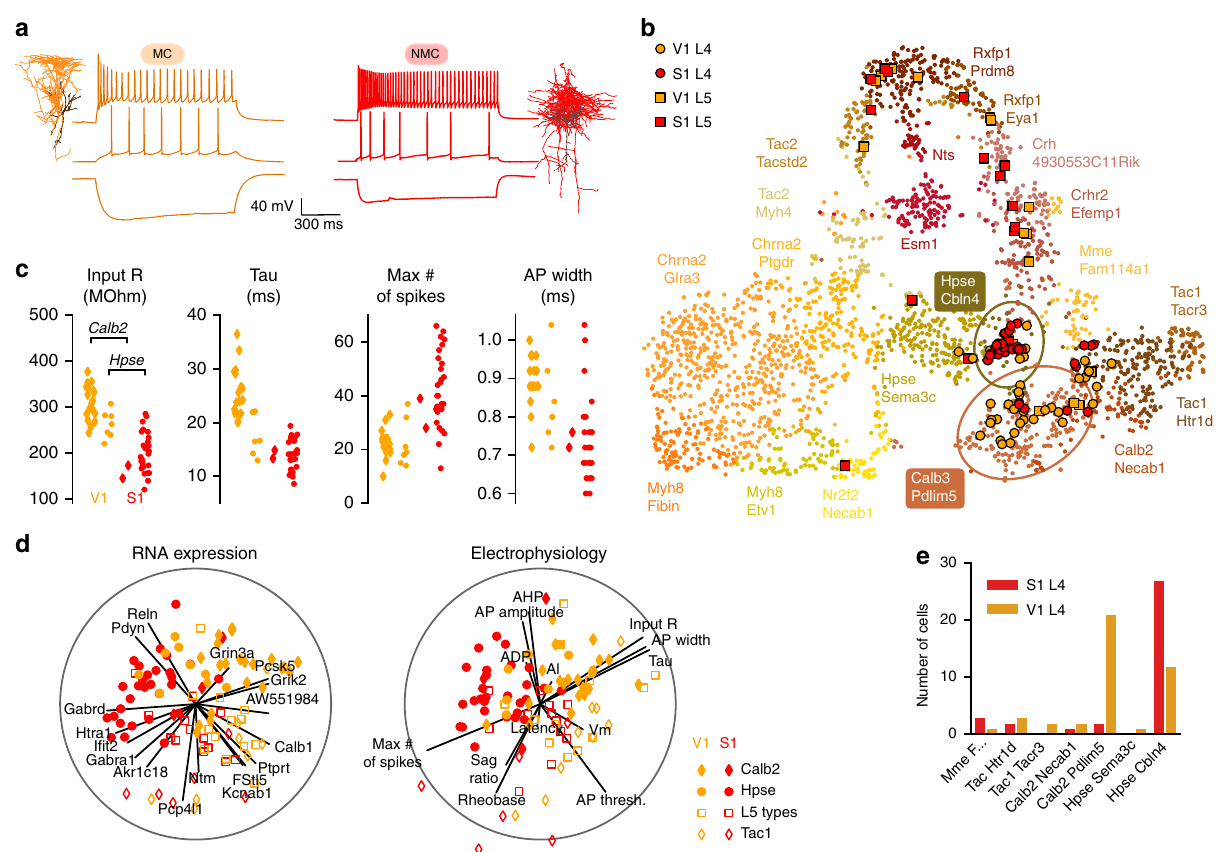
Fig. 4 Transcriptomic and electrophysiological differences between L4 SOM + interneurons in V1 and S1. a Morphologies and fi ring patterns of two exemplary cells, from V1 (orange) and S1 (red), respectively. b Mapping of the Patch-seq cells ( n = 110) to the t-SNE visualization of the transcriptomic diversity among Sst types from Tasic et al. 25 t-SNE was done on all cells from Sst types except for Sst Chodl that is very well separated from the rest (20 clusters; n = 2701 cells), using 500 most variable genes (see Methods). Two ellipses show 90% coverage areas of the two types where the most Patch- seq cells land. Mapping to t-SNE was performed as we described elsewhere 85 , see Methods. “ Sst ” was omitted from type names for brevity. c Four electrophysiological features that differed most strongly (Cohen ’ s d > 1) between V1 L4 and S1 L4 cells. Only cells assigned to Sst Calb2 Pdlim5 and Sst Hpse Cbln4 types are shown. Note that the values are not directly comparable to those shown in Supplementary Fig. 5 because Patch-seq experiments used a different internal solution compared to regular patch-clamp experiments without RNA extraction. d Sparse reduced-rank regression analysis 48 : the left biplot shows two-dimensional projection in the transcriptomic space that is optimized to reconstruct the electrophysiological features. The right biplot shows the corresponding two-dimensional projection in the electrophysiological space; it should match to the left plot if the model is accurate. Color denotes brain area (orange for V1, red for S1), marker shape denotes transcriptomic type that each cell was assigned to (circles: Hpse Cbln4 type; diamonds: Calb2 Pdlim type; open diamonds: three Tac1/Mme types and the neighbouring Calb2 Necab1 type; open squares: all other types). Individual electrophysiological features and genes selected by the model are depicted with lines showing their correlations to the two components. Circles show maximal possible correlation. Cross-validated estimate of the overall R-squared was 0.14, and cross-validated estimates of the correlations between the horizontal and vertical components were 0.69 and 0.49, respectively. e Type assignments of the Patch-seq cells from